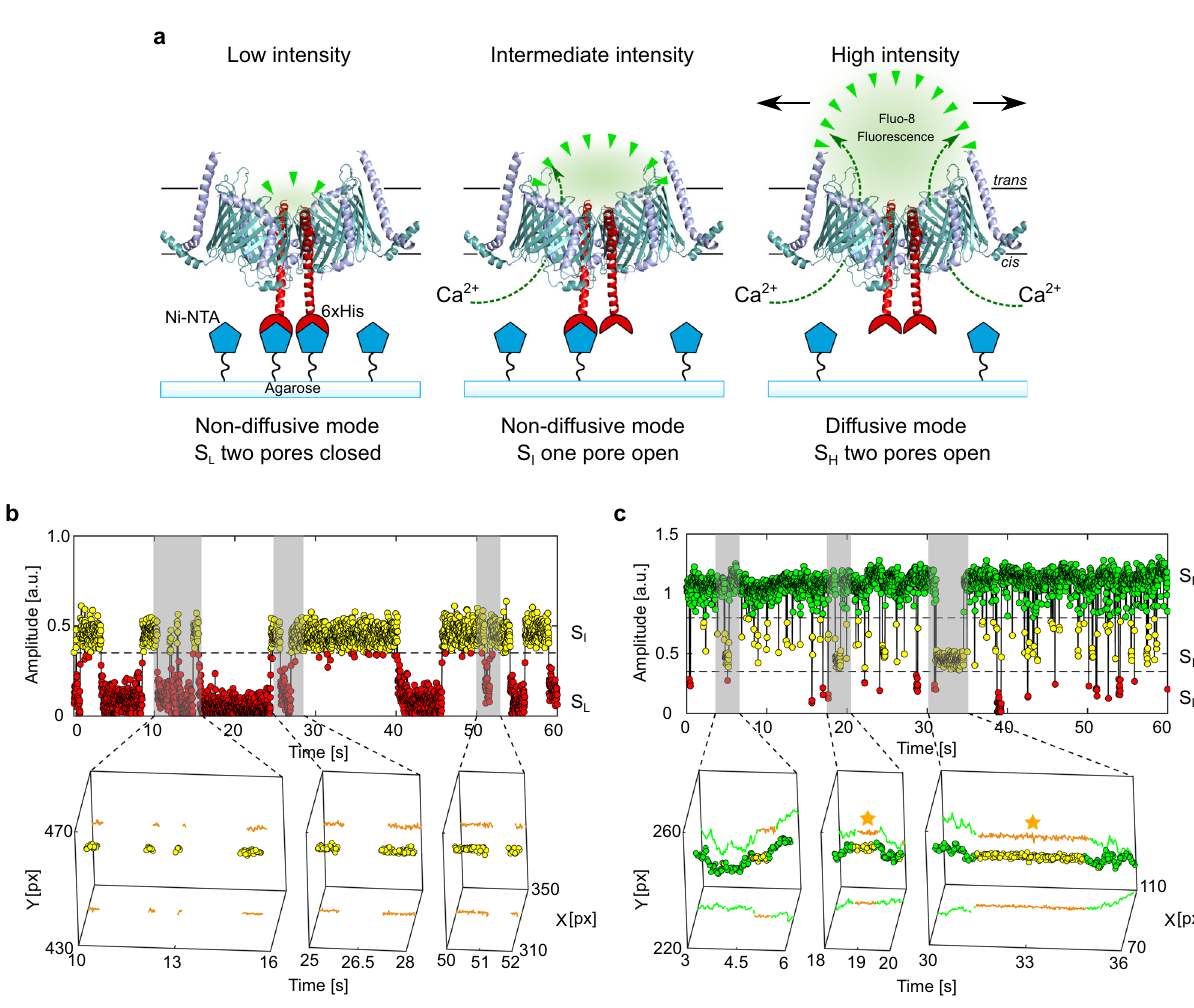
Fig. 4 Controlled immobilization of TOM-CC triggers channel closures. a Schematic representation of individual TOM-CC channels in DIB membranes supported by Ni-NTA-modi fi ed agarose. TOM-CC molecules can be permanently linked to the underlying hydrogel via His-tagged Tom22. Tethered and non-tethered TOM-CC molecules in closed (S I and S L ) and open (S H ) states are indicated, respectively. b Fluorescent amplitude trace (top) of a TOM-CC channel permanently tethered to Ni-NTA-modi fi ed agarose. The trajectory segments (bottom) correspond to the time periods of the amplitude traces marked in gray (Supplementary Movie S7: bottom). Non-diffusive, permanently immobilized TOM-CC is only found in S I or S L , indicating that tight binding of the His-tagged Tom22 domain (Fig. 1b) to Ni-NTA-modi fi ed agarose triggers closure of the β -barrel TOM-CC pores. c Fluorescence amplitude trace (top) of a TOM-CC channel transiently and non-speci fi cally entangled by Ni-NTA-modi fi ed agarose. The trajectory segments (bottom) correspond to the time periods of the amplitude traces marked in gray. The movement of TOM-CC is interrupted twice at the same spatial x , y membrane position from t 1 = 18.56 s to t 2 = 19.19 s and from t 3 = 31.14 s to t 4 = 34.55 s (yellow stars). Consistent with the data shown in Fig. 3, moving TOM-CC molecules in diffusive mode are found in the fully open S H state; transient tethering causes the TOM-CC β -barrels to close. Data were acquired as described in Fig. 1c at a frame rate of 47.5 s − 1 . A total of n TOM = 123 amplitude traces and trajectories were analyzed. a.u. arbitrary